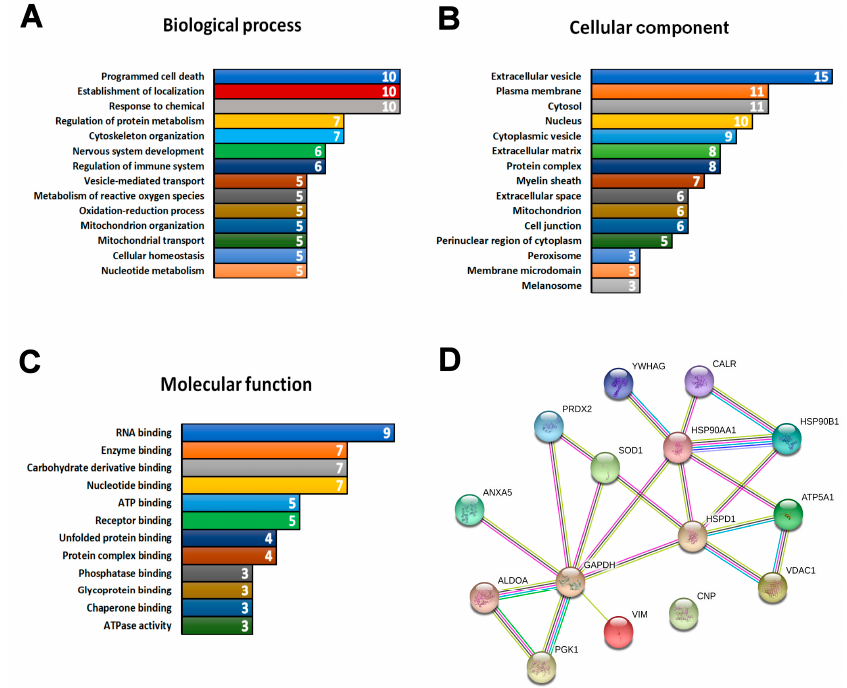
Figure 3. Bioinformatics analysis of the 15 proteins differentially expressed in both SMA and ALS proteomic studies. Gene ontology analysis revealed enriched terms connected to ( A ) biological process, ( B ) cellular component, and ( C ) molecular function. In the biological process domain, only terms with five or more annotated proteins are presented. Terms are presented as bars, with the white numbers inside the bars indicating number of annotated proteins. The full list of terms together with annotated proteins is available in Table S7. ( D ) STRING 10 association network of proteins that were differentially expressed in SMA and ALS. Proteins connected to metabolic function, oxidative stress response and protein stability were identified in the network from Figure 3A. The type of the association between proteins is indicated by the color (pink: experimentally determined interactors; light blue: interactors form curated databases; grey: protein homology; black: co-expression; yellow: text-mining; dark blue: gene co-occurrence; green: gene neighborhood).